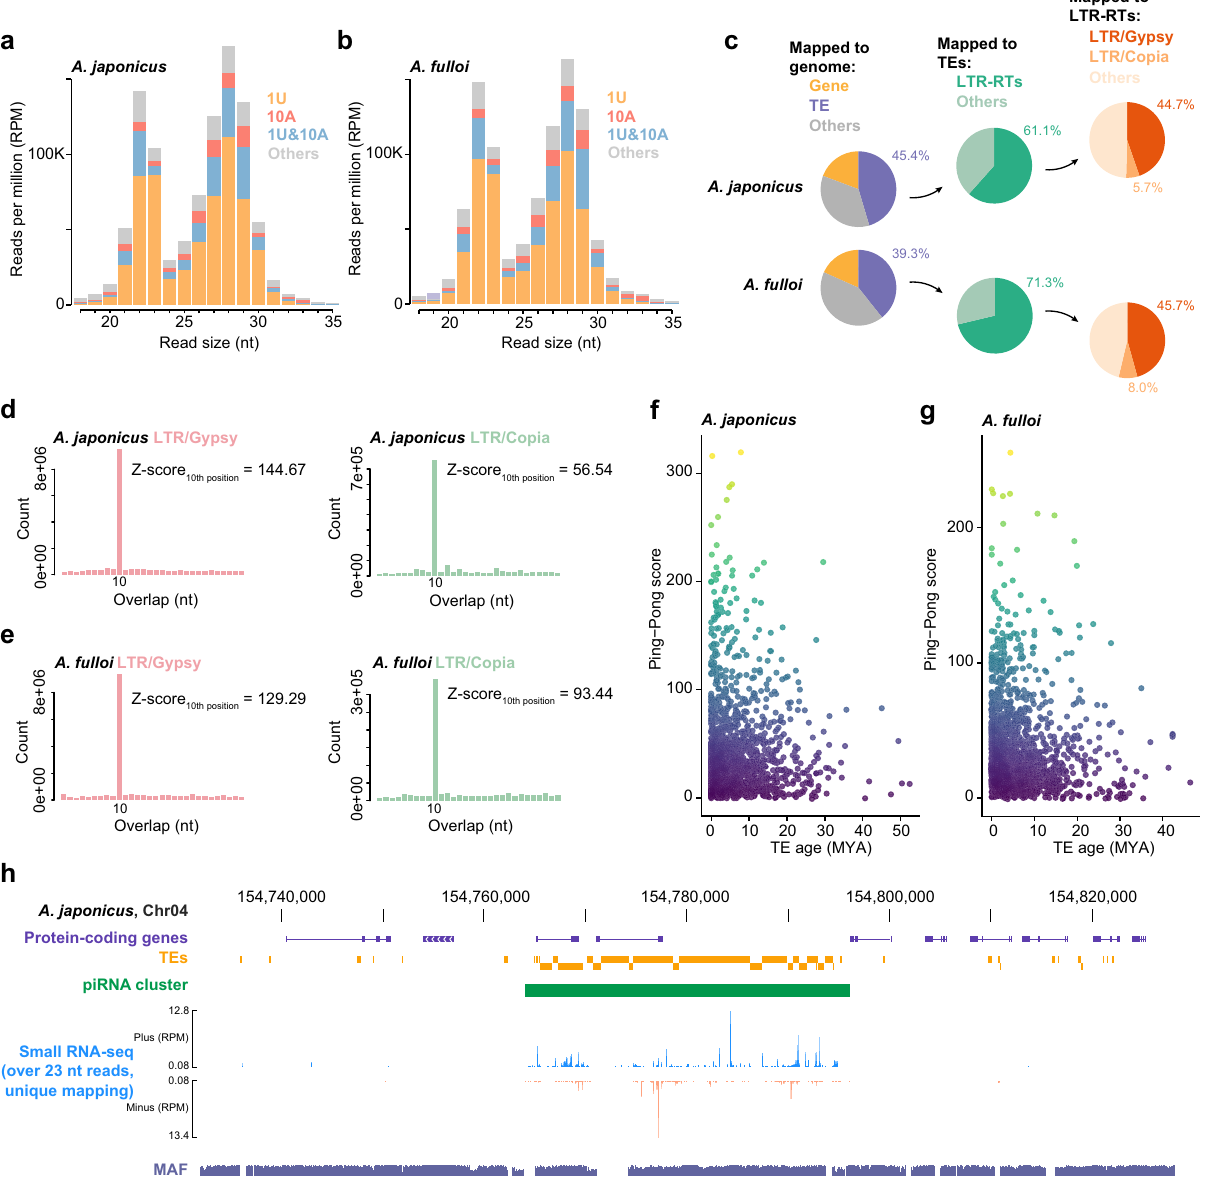
shown( e ).Thesigni fi canceoften-nucleotideoverlap( ‘ Ping-Pong ’ )wasdetermined using Z-score. f , g Scatter plots illustrating the relationship between TE ages (LTR retrotransposons) and Ping-Pong scores in the two Anastatus genomes. h Genome browserviewrevealingalargenumberofpiRNAsproducedfromaTE-richregionin the A. japonicus genome. Source data are provided as a Source Data fi